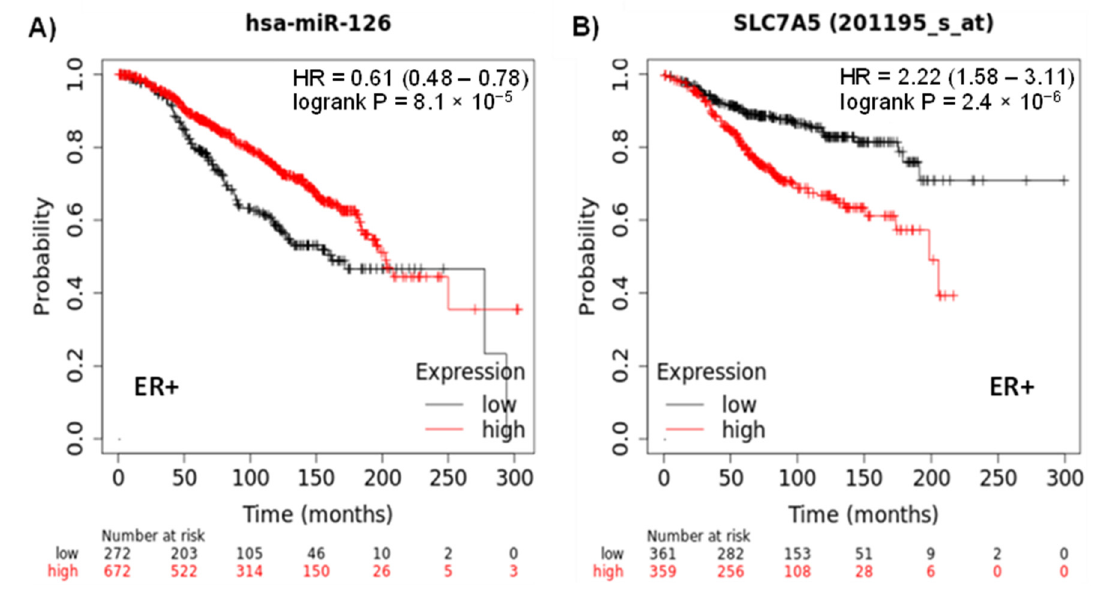
Figure 6. Correlation of the expression of miR-126 or SLC7A5 with overall survival (OS) of ER+ BC patients. In silico Kaplan–Meier plot of ( A ) hsa-miR-126 expression with OS of 944 ER+ BC patients, ( B ) SLC7A5 expression with OS of 720 ER+ BC patients. HR: hazard ratio